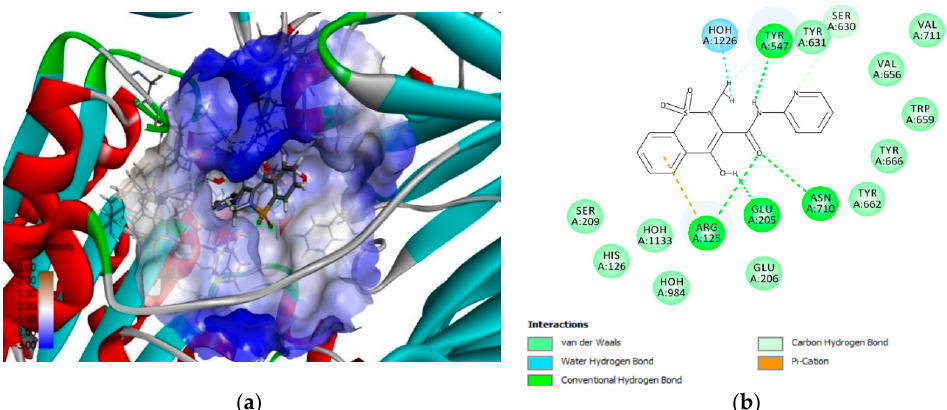
Figure 3. DPP-4 interactions with piroxicam generated using the FlexX docking algorithm. ( a ) The binding pose view of piroxicam at the active site of DPP-4 and the hydrophobic surface visualized